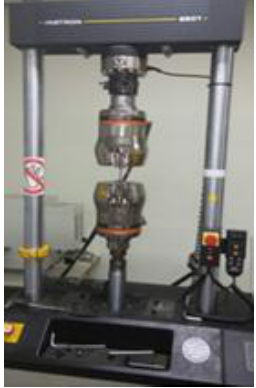
Figure 6. Test equipment (10 tons, Instron 8801).